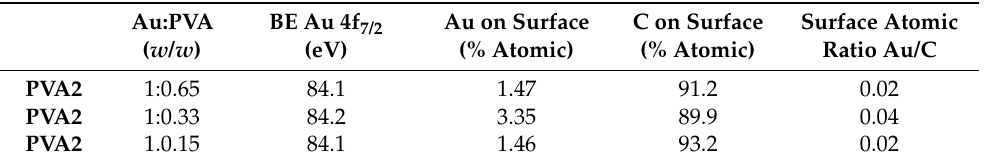
Table 9. XPS data for 1% wt. Au/AC synthesized using PVA2 (Mn = 13,000–23,000) with different Au:PVA weight